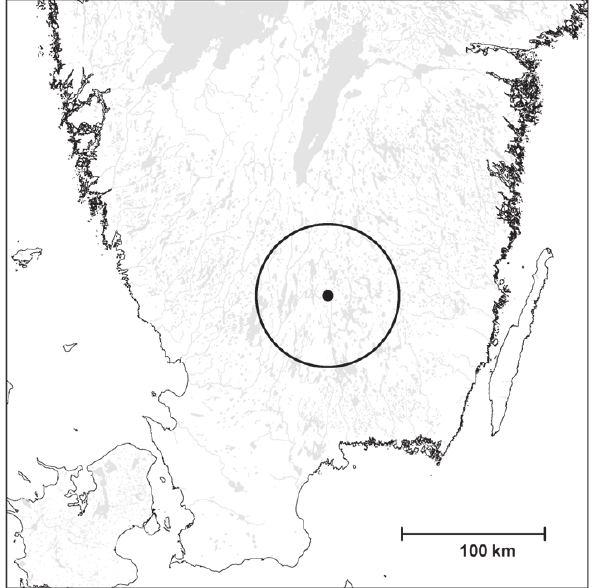
Fig. 1. Study area in the south Swedish Uplands. The circle repre- sents the reconstructed area within a 50km radius from Lake Fiolen which is situated in the